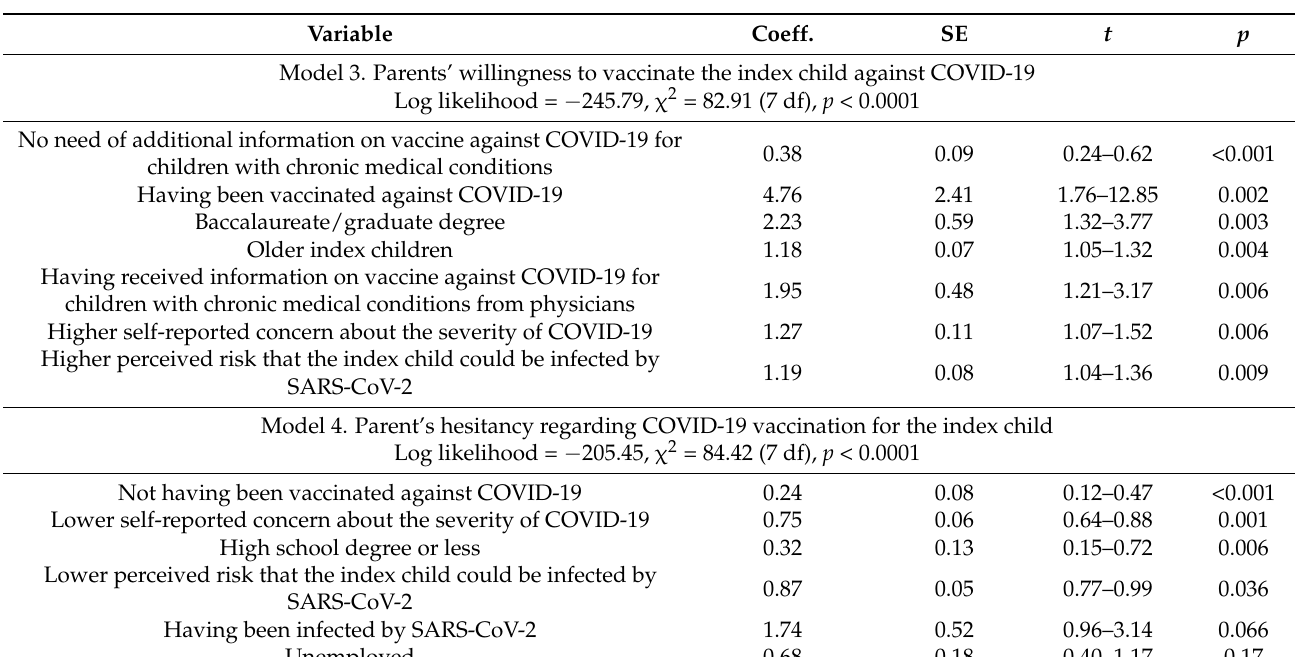
Table 2. Cont. Variable Coeff. SE t